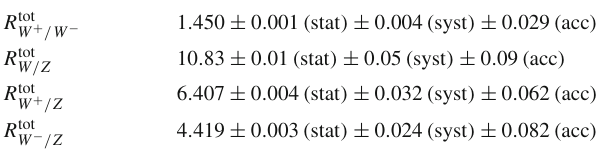
Table 8 Ratios of integrated fiducial CC and NC cross sections obtained from the combination of electron and muon channels with statistical (stat) and systematic (syst) uncertainties. The common fidu- cial regions are defined in Sect. 2.3 R fid W + / W −